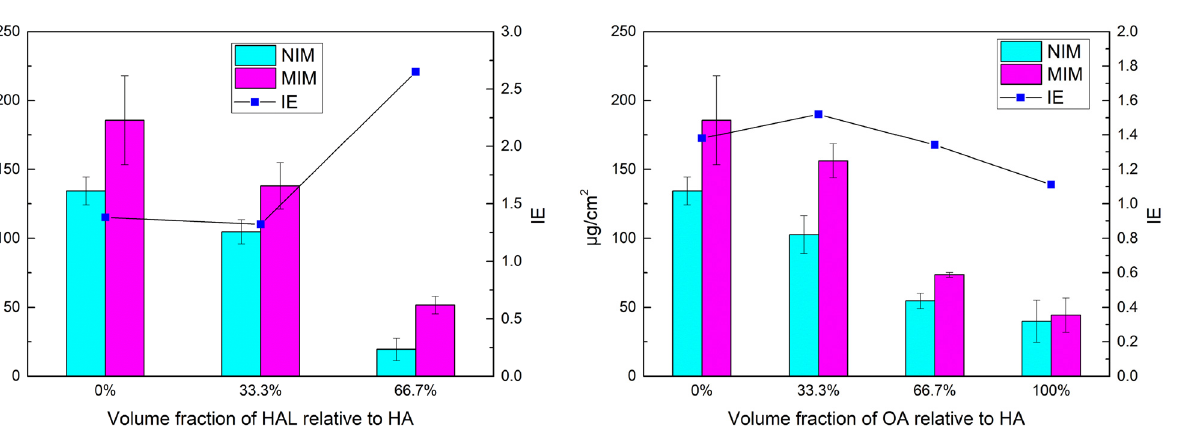
Figure 12: Adsorption capacities and imprinting e ffi ciency of dif - ferent volume fractions of HAL relative to HA.